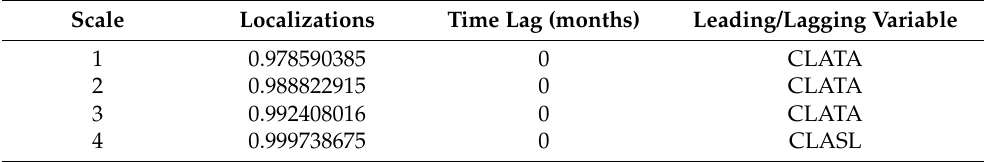
Table 7. WMCC among the indicators of GSE, banking sector financial Soundness, and interest